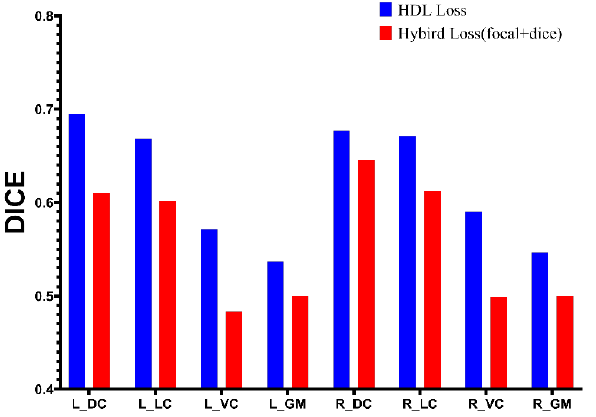
Figure 6. The performance comparison of UNet with different losses. Table 1. The performance of UNet with proposed HDL loss.